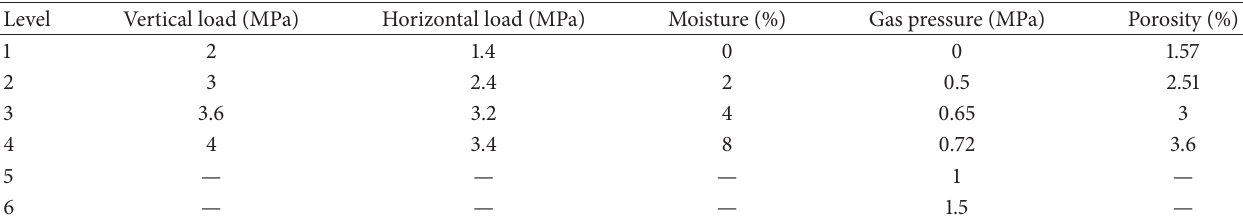
Table 1: Experiments program.